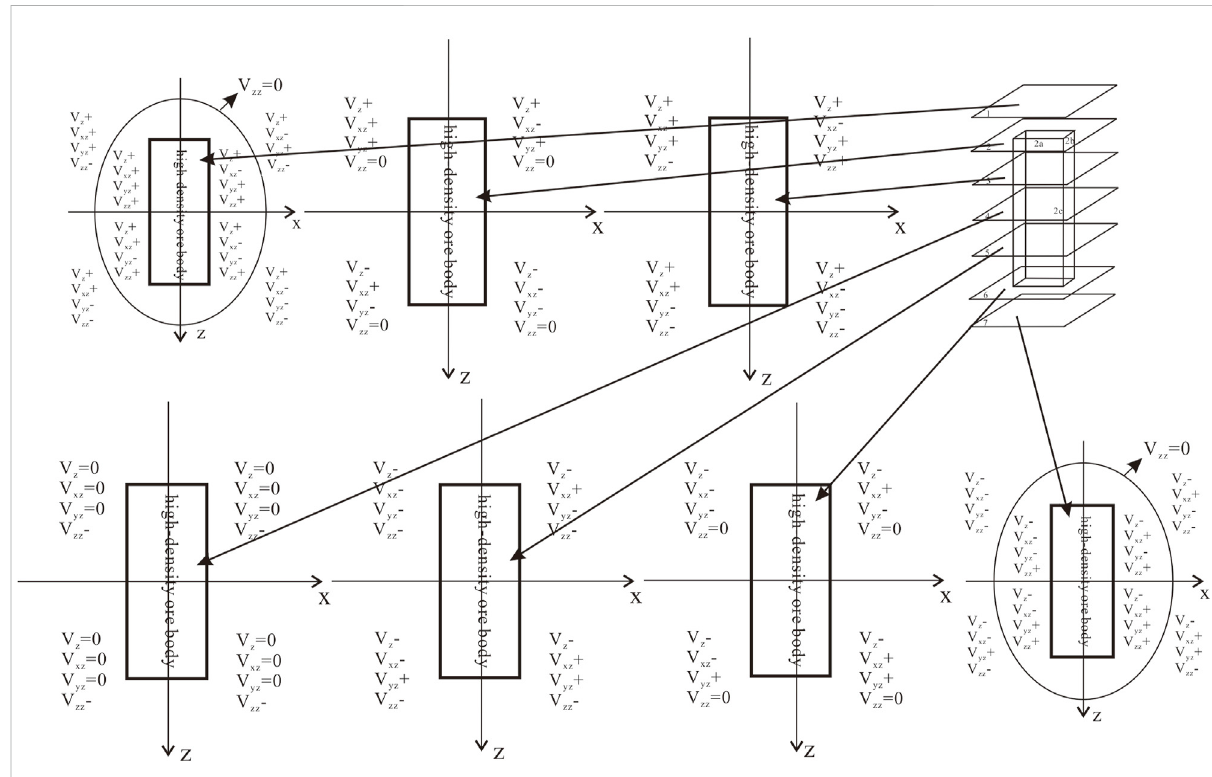
FIGURE 5 Combinations of the four parameters at different sections of the vertical